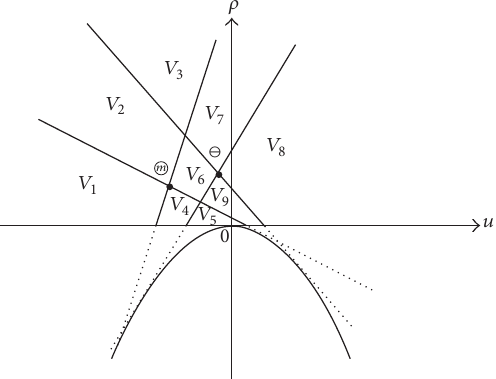
Figure 2: If (𝑢 𝑚 , 𝜌 𝑚 ) ∈ I (𝑢 − ,𝜌 − ) , then the nine different regions in the half-upper (𝑢, 𝜌) phase plane are shown for the perturbed Riemann problem (1) and